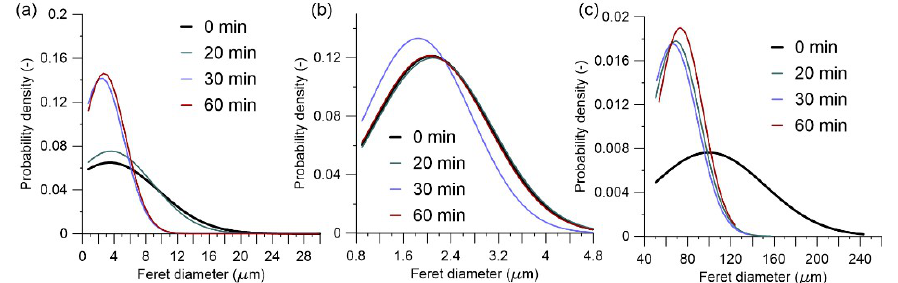
Figure 8. Particle size distribution of a Swedish raw clay at different grinding duration for diameter ranges: ( a ) entire range; ( b ) clay particle size range; ( c ) agglomerates over 50 μm range.